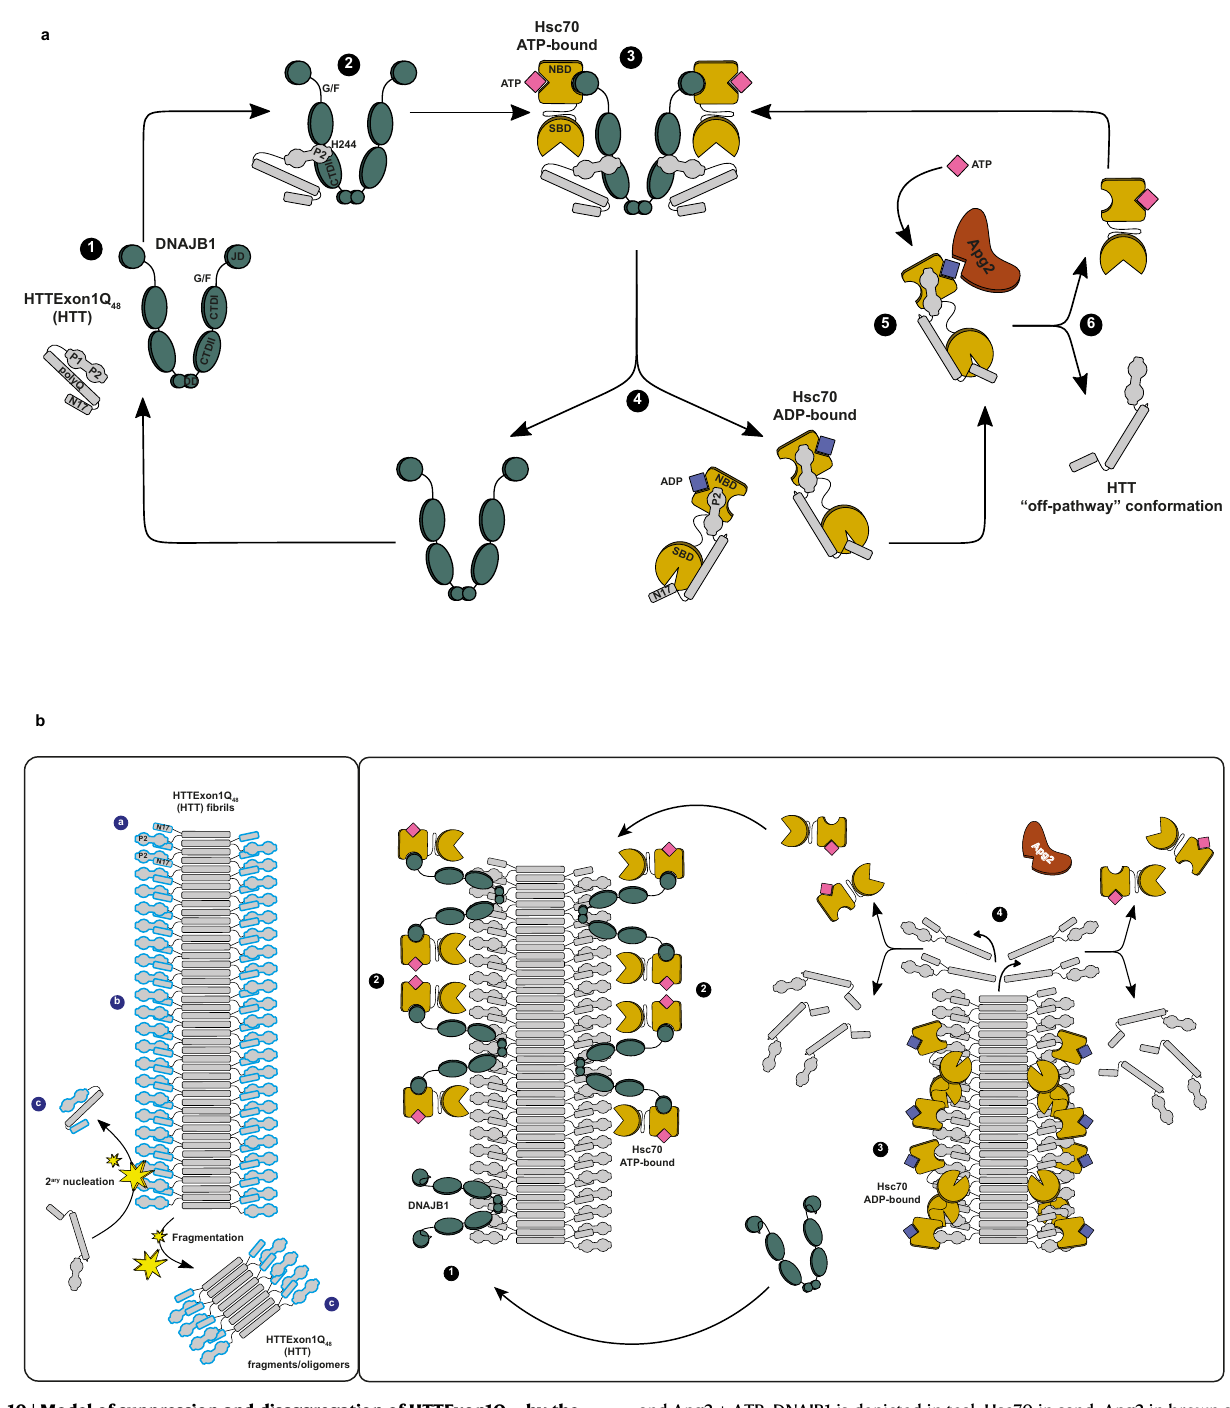
Western blotting analysis and fi lter-retardation assay Western blotting and fi lter-retardation analysis were performed simi- larly as previously described 18 . Cell pellets were incubated for 30min oniceinlysisbuffer(50 mMTris-HClpH7.4,150 mMNaCl,1mMEDTA, 1% Triton X-100, and 1 tab/50ml of complete protease cocktail inhi- bitor(Roche)).Lysateswerecentrifugedat4 °Cfor20 minat20.000× g and the soluble and insoluble fractions were separated and used, respectively, for Western blotting and fi lter-retardation assay. For